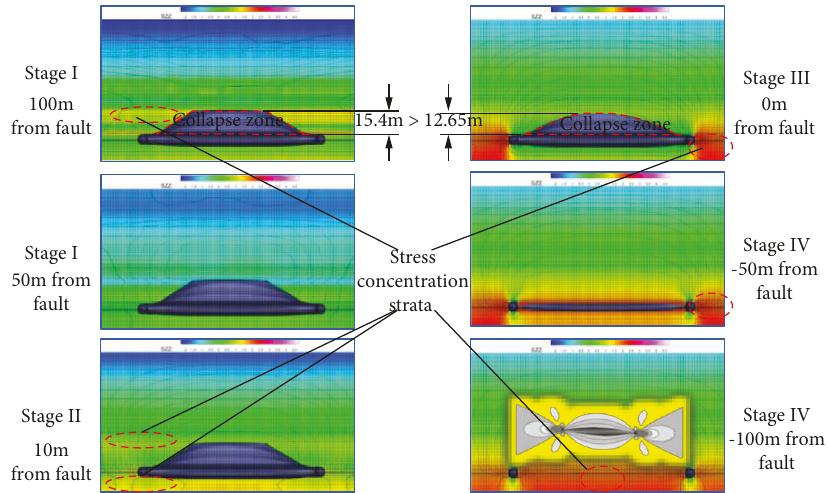
Figure 6: Evolution law of stress field in surrounding rock of stope at different stages of